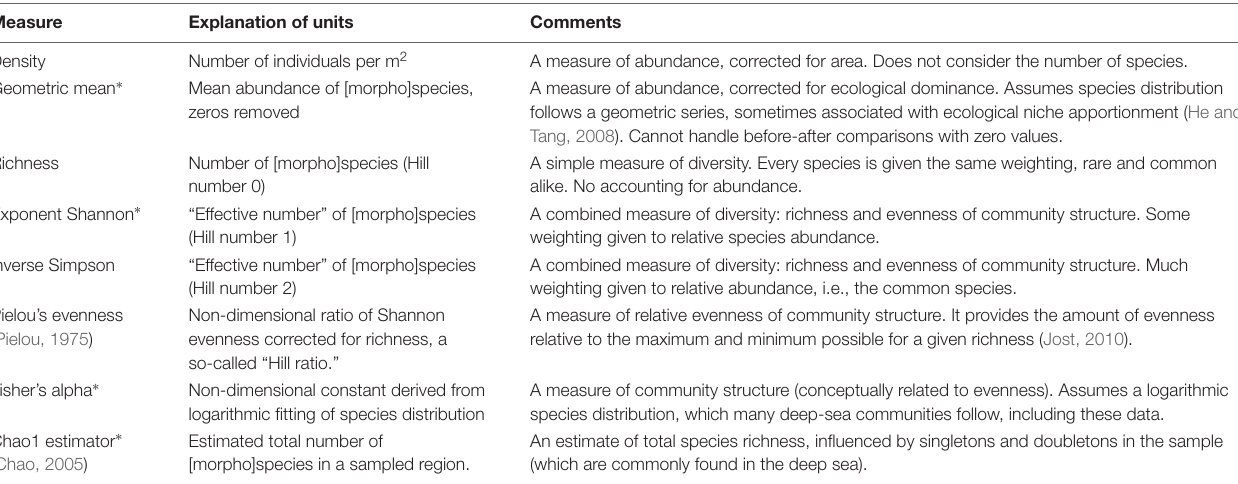
TABLE 1 | Metrics used to detect changes in biodiversity and other ecological